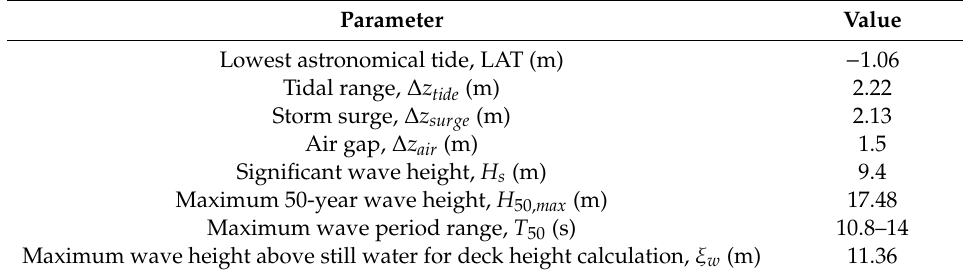
Figure 2. Representation of the loads on the support structure of the offshore wind turbine (OWT) and jacket geometry embedded in layered soil. Table 1. Water levels and wave data of interest for the K-13 deep-water site.